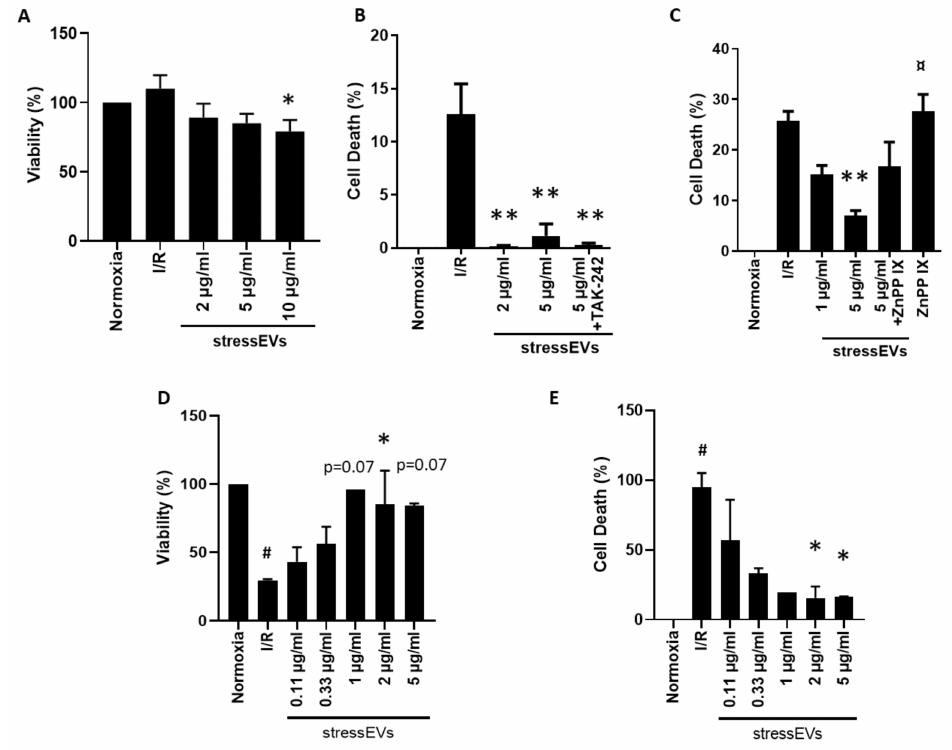
Figure 6. StressEVs protect against simulated I / R-induced cytotoxicity via HO-1 activity. ( A ) H9c2 cells were incubated for 4 h with increasing concentrations of stressEVs in normoxic conditions. The cell viability of H9c2 cells was determined by the Calcein-AM assay. ( B , C ) H9c2 cells were pre-incubated with either TAK-242 (2.5 µ M) or ZnPP IX (1 µ M) for 1 h prior to stressEV stimulation (1 or 2 and 5 µ g / mL) for 6 h before I / R. LDH release was determined. ( D , E ) AC16 cells were preincubated with stressEVs (0.1–5 µ g / mL) for 4 h before I / R. Viability was measured by the Calcein-AM assay ( D ) and cytotoxicity was determined by the CytoTox-Glo assay ( E ). Data are representative of three ( A – C ; n = 5) or two ( D – E ; n = 6) independent experiments (* p < 0.05 ** p < 0.01 vs. I / R; # p < 0.05 vs. normoxia; ¤ p < 0.05 vs. 5 µ g / mL stressEVs + ZnPP